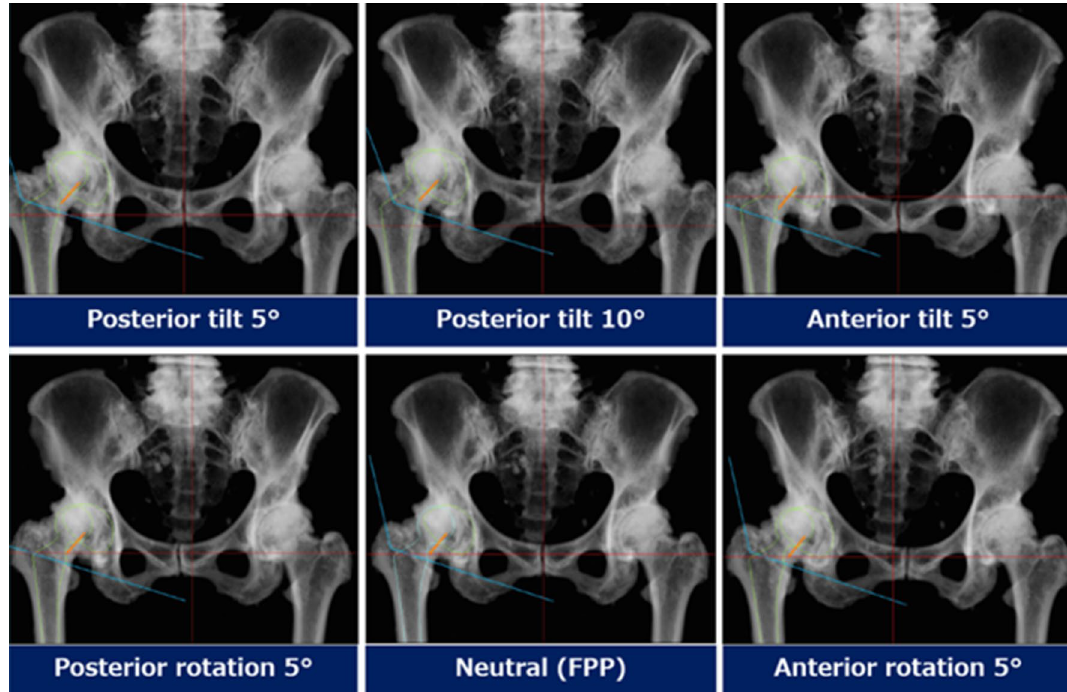
Figure 2. Several patterns of digitally reconstructed radiographs of the pelvis include a pelvis in the functional pelvic plane (FPP) and pelvises that changed pelvic tilt or pelvic rotation from the FPP. The pelvic position is adjusted based on these images just before surgery.